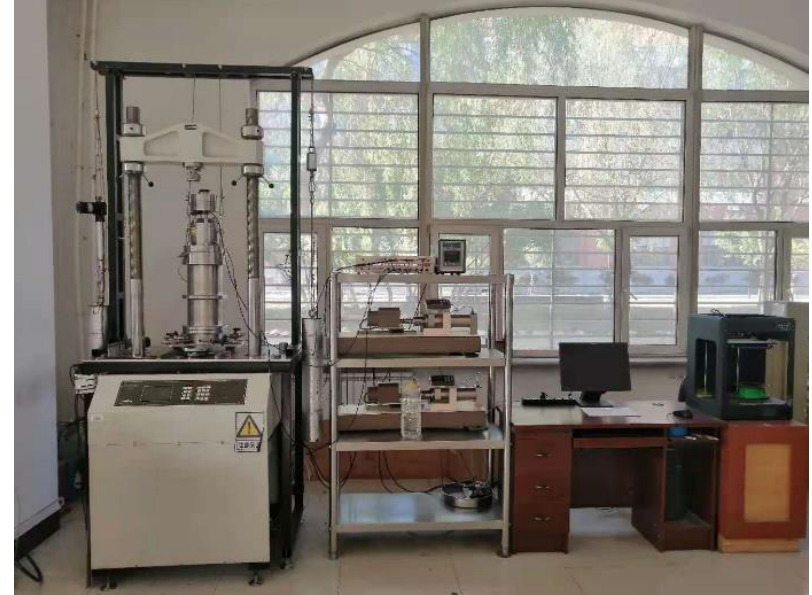
Figure 2. Soft rock rheometer.